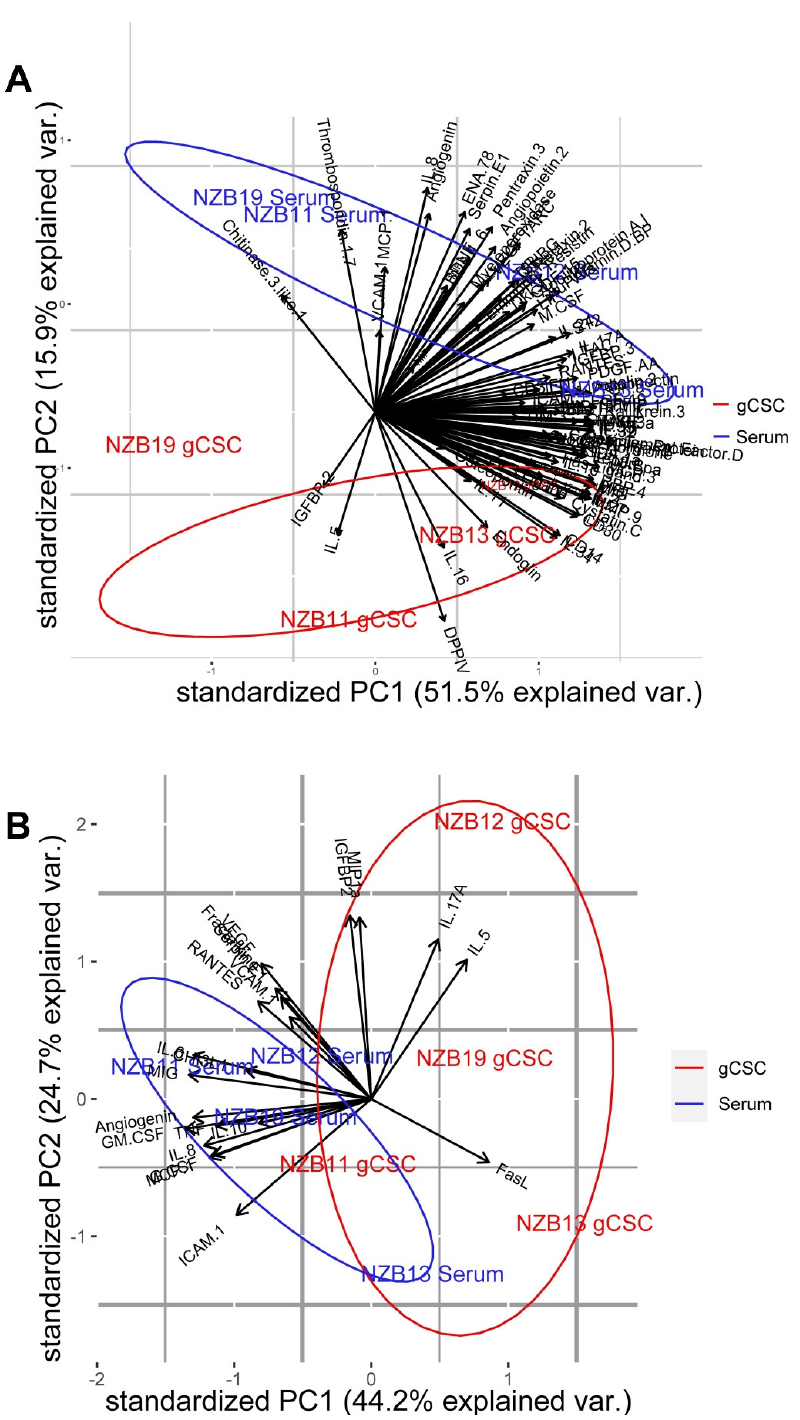
Figure 5. Principal Component analysis of key cytokines, chemokines and immune modulators in 4 GBM cell lines cultured as serum or stem-like cells. Principal component analysis was carried out on ( A ) mean log10 transformed proteome profiler intensities and ( B ) mean log10 cytometric bead array and luminex concentrations. The first and second principal components show 51.5% and 15.9% (Proteome Profiler), and 44.2% and 24.7% (CBA and Luminex) of the total variance,